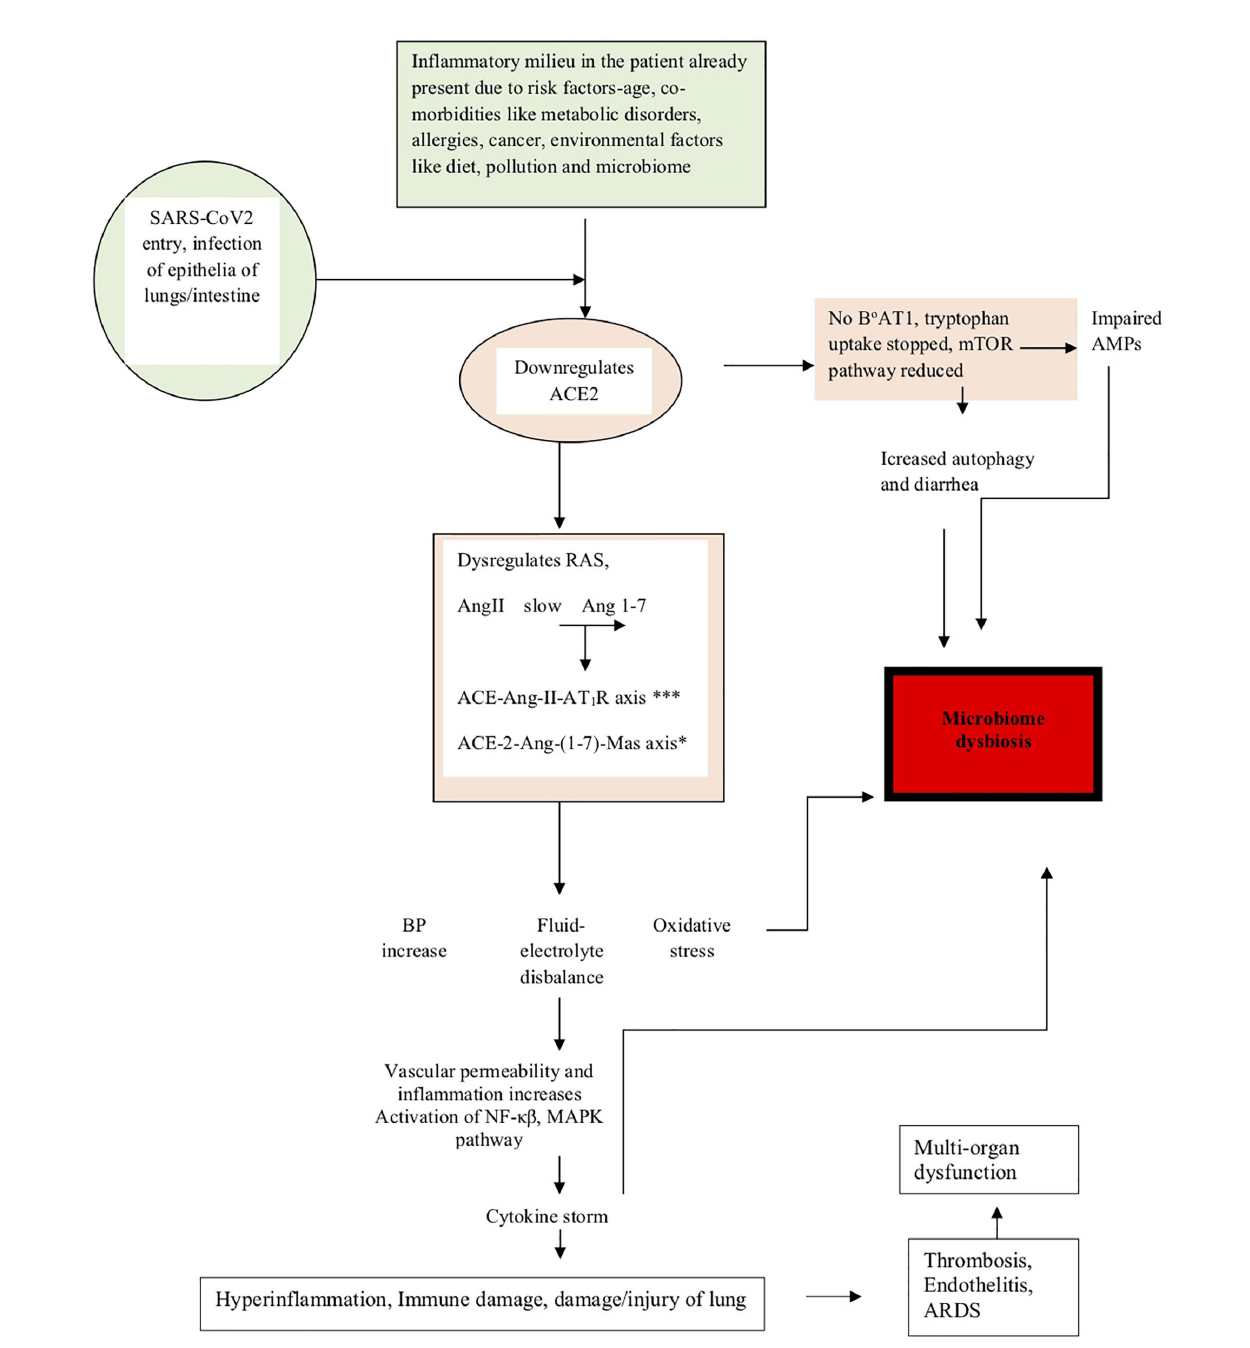
FIGURE 1 | The fi gure shows how the pathogenesis of SARS-CoV-2 affects the microbiome. The diagram shows that in people already predisposed toward the disease due to age, comorbidities, and environmental factors like pollution, diet, and microbiome, the pathogenesis is facilitated due to prior downregulation of the ACE2 receptor, which is the major receptor for SARS-CoV-2 entry into the lung epithelia. On viral entry, ACE2 is further downregulated and initiates a cascade of events like dysregulation of RAS, slows conversion of AngII to Ang 1-7, upregulation of the ACE-Ang-II-AT 1 R axis (indicated by *** in the fi gure) and downregulation of the ACE-2-Ang-(1-7)-Mas axis (indicated by * in the fi gure), leading to clinical symptoms like an increase in blood pressure, imbalance of fl uids and electrolytes, oxidative stress, vascular permeability alterations, and eventually increase in in fl ammation leading to the cytokine storm accentuated by the activation of NF- kb , MAPK pathway, and fi nally leading to lung damage. Downregulation of ACE2 also leads to the absence of the tryptophan transporter B°AT1 leading to the inhibition of tryptophan uptake, which consequently leads to the reduction of the mTOR pathway, impaired expression of antimicrobial peptides (AMPs), and increase in autophagy leading to diarrhea and dysbiosis of the microbiome. Microbiome dysbiosis in COVID-19 has been found to be characterized by the upsurge of certain taxa and decrease of others, as indicated in Table 2 .